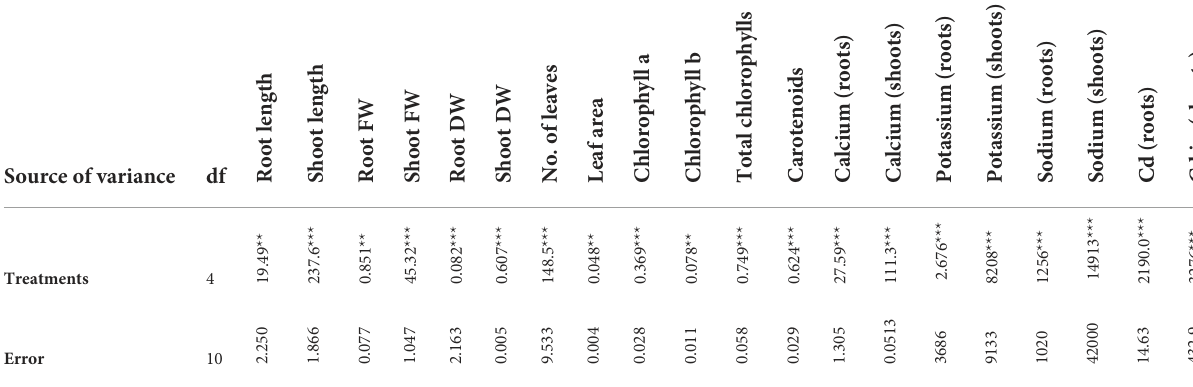
TABLE 3 ANOVA of various attributes of P. hysterophorus in response to Set-2 of treatments.